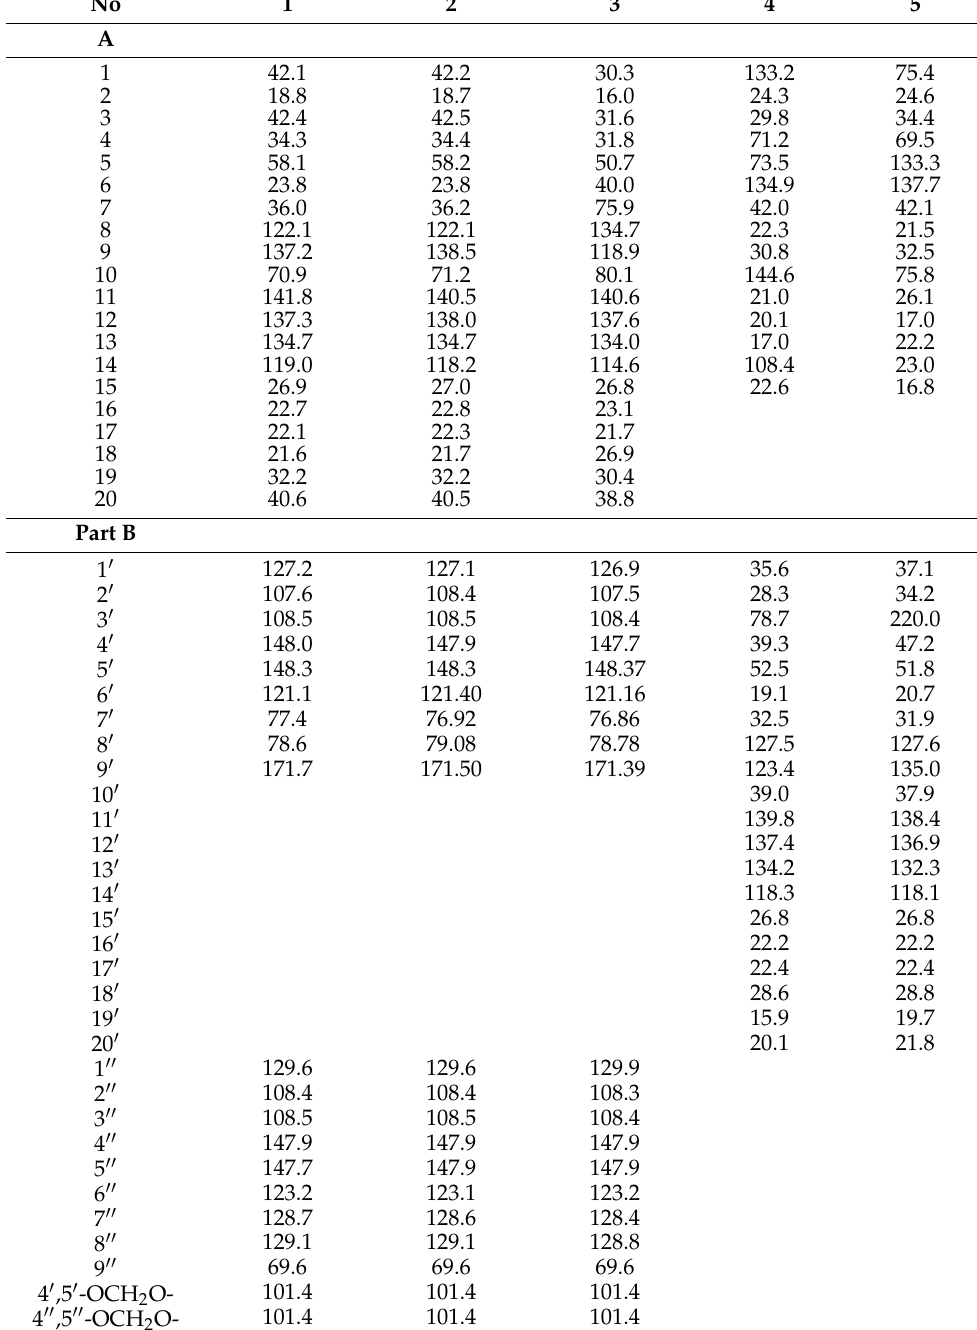
Table 2. 13 C NMR data for compounds 1 – 5 ( δ in ppm, 125 MHz for 13 C NMR in CDCl 3